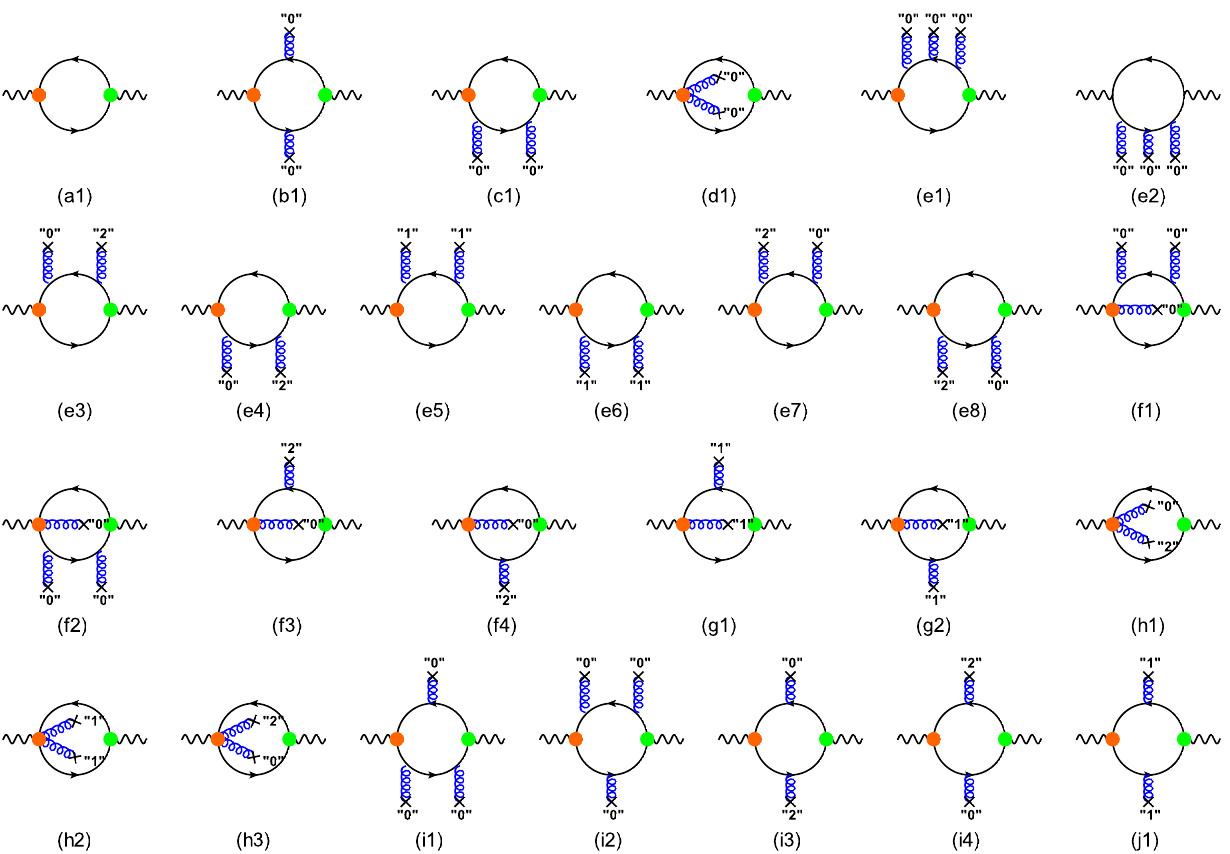
Fig. 1 Feynman diagrams for the first term of Eq. (18). The left big dot tothegluonlineindicatesthetensorofthelocalgluonbackgroundfield, ↔ and “ n ” indicates n th -order covariant derivative. The diagrams whose and the right big dot stand for the vertex operators (cid:13) z γ 5 ( z · D ) n and (cid:13) z γ 5 contributions vanish in the sum rules are not shown ( 0 ) ,respectively.Thecrosssymbolattached inthecurrents J n ( x ) and J † 0